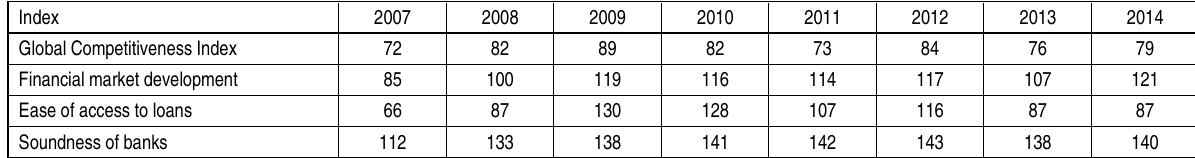
Table 1. Rating of indices of financial market development in Ukraine